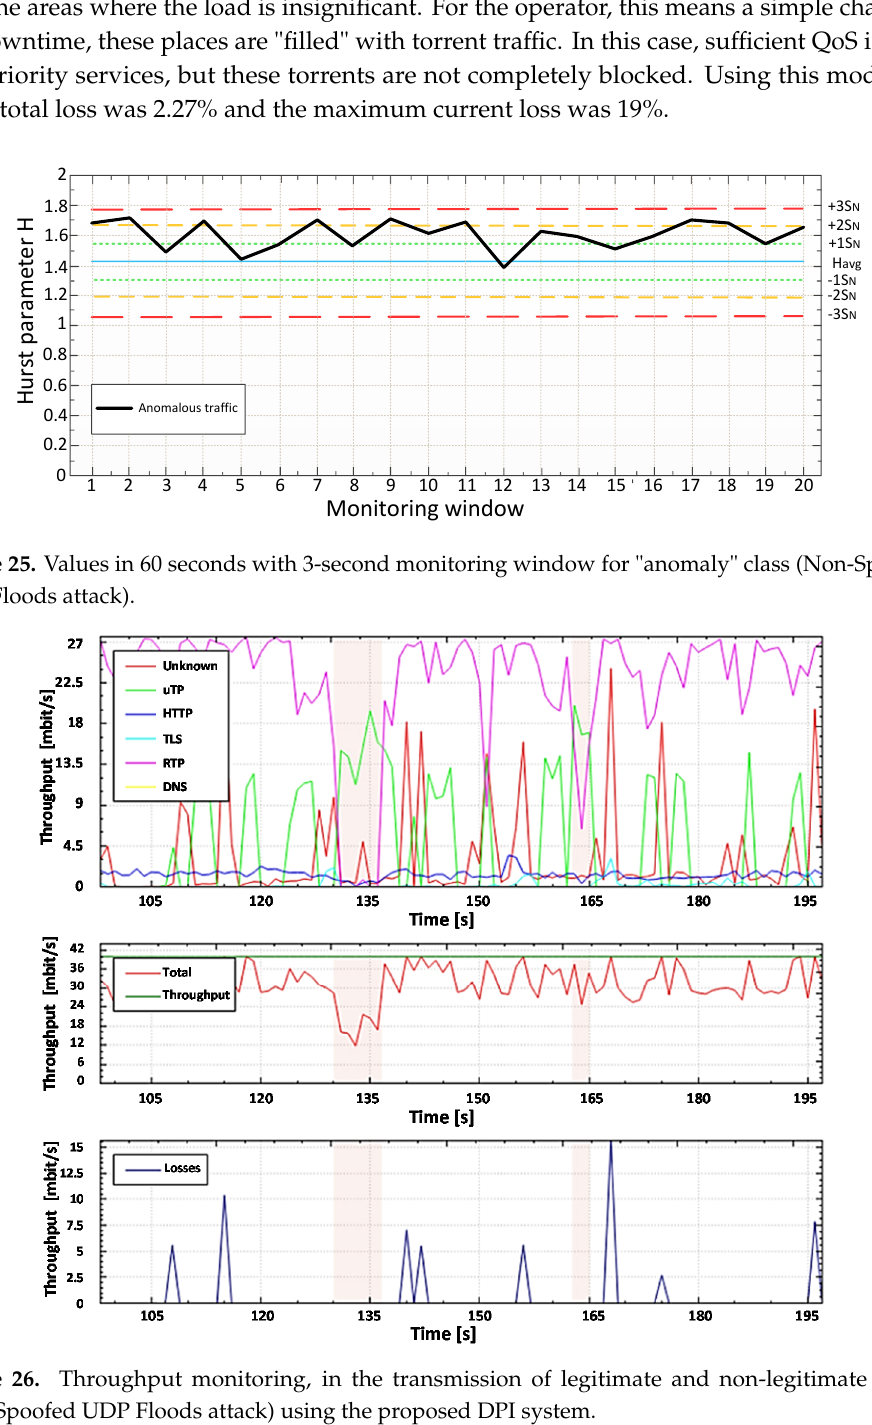
Figure 26. Throughput monitoring, in the transmission of legitimate and non-legitimate traffic (Non-Spoofed UDP Floods attack) using the proposed DPI system.